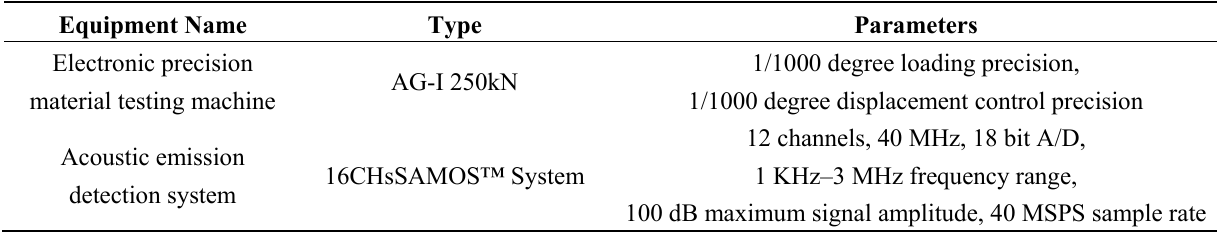
Figure 6. Specimens in acoustic emission test. Table 2. Basic parameter of equipment.